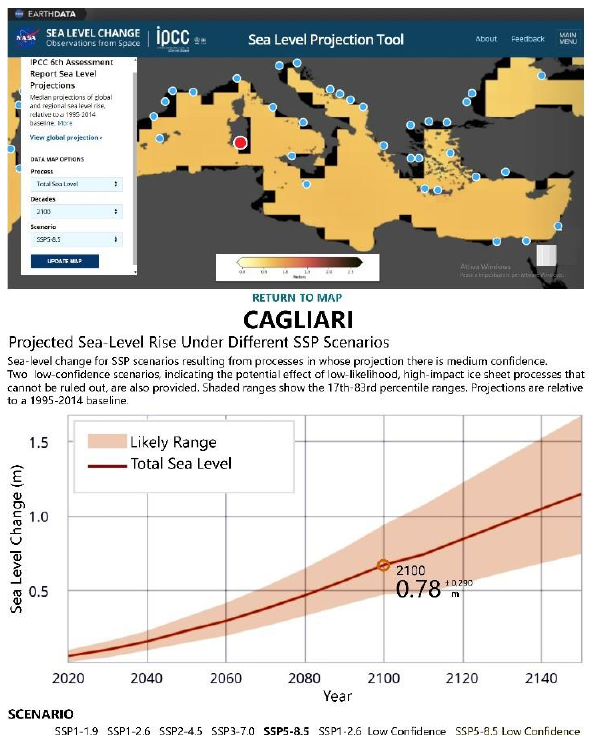
Figure 22. Projected Sea Level Rise of Cagliari coastal plane after IPCC AR6 [18] — https://sealevel.nasa.gov/ipcc-ar6-sea-level-projection-tool. (accessed on 28 Agoust 2021).